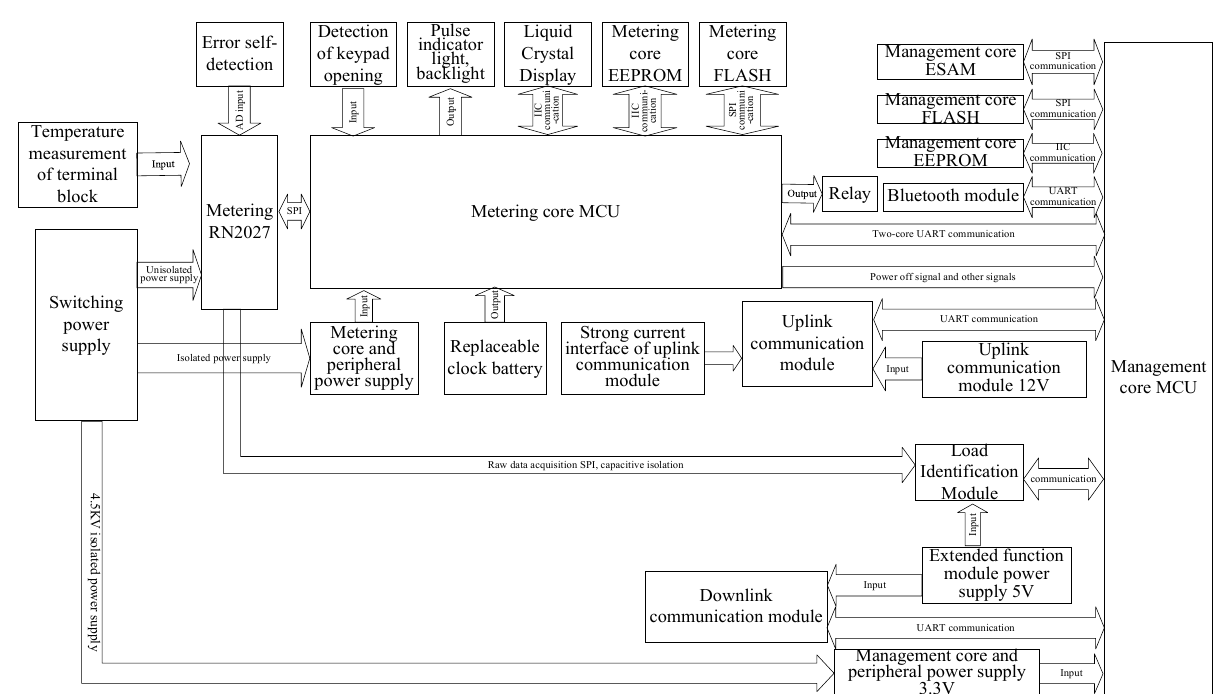
Figure 1. Working principle diagram of a smart meter.